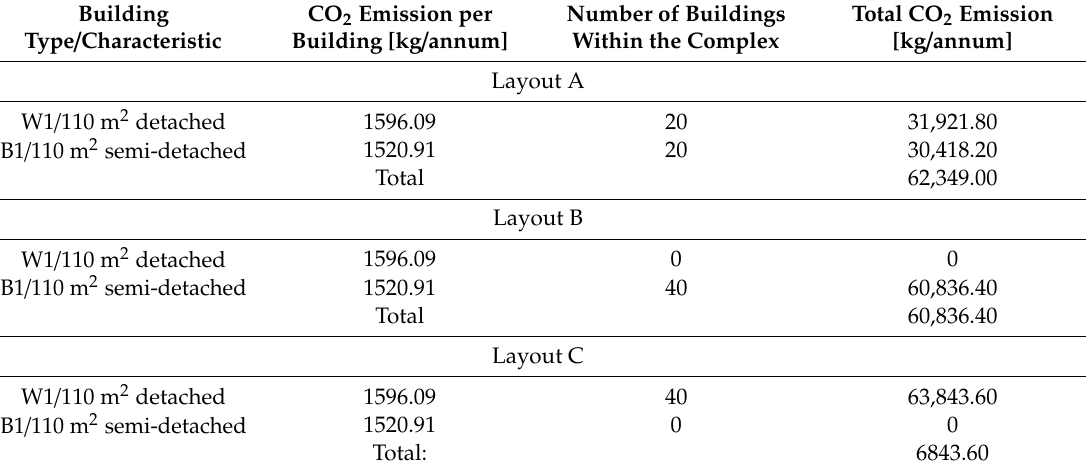
Table 10. Summary of CO 2 emissions per building type and for each layout